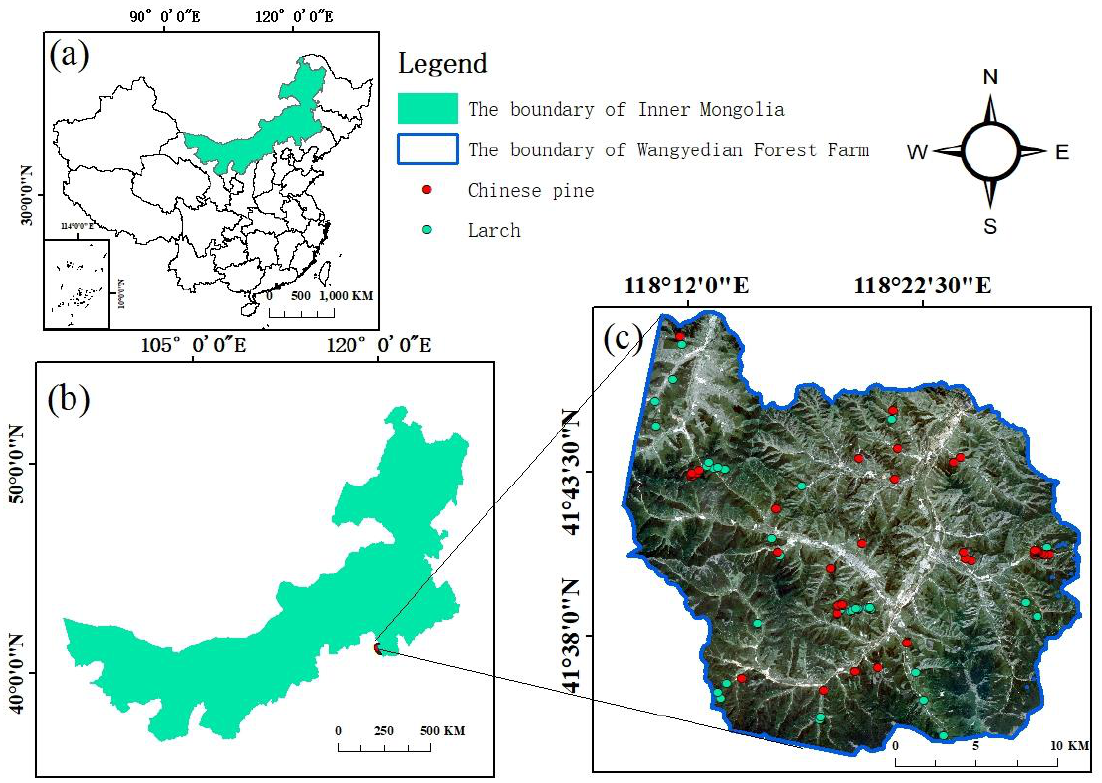
Figure 1. ( a ) and ( b ) The location of the study area in North China and Inner Mongolia; and ( c ) the spatial distribution of larch and Chinese pine plots.